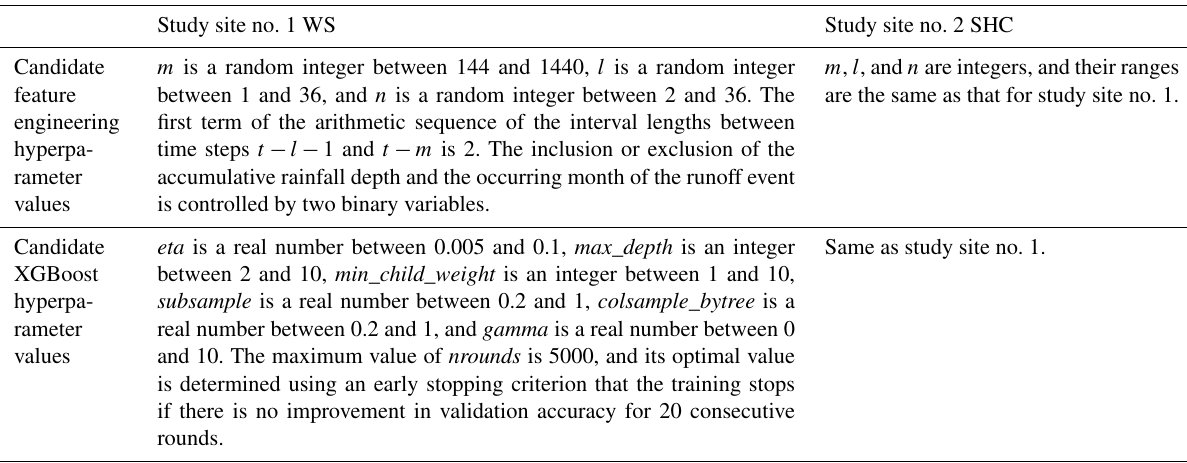
Table 1. Hyperparameter values considered for the two study